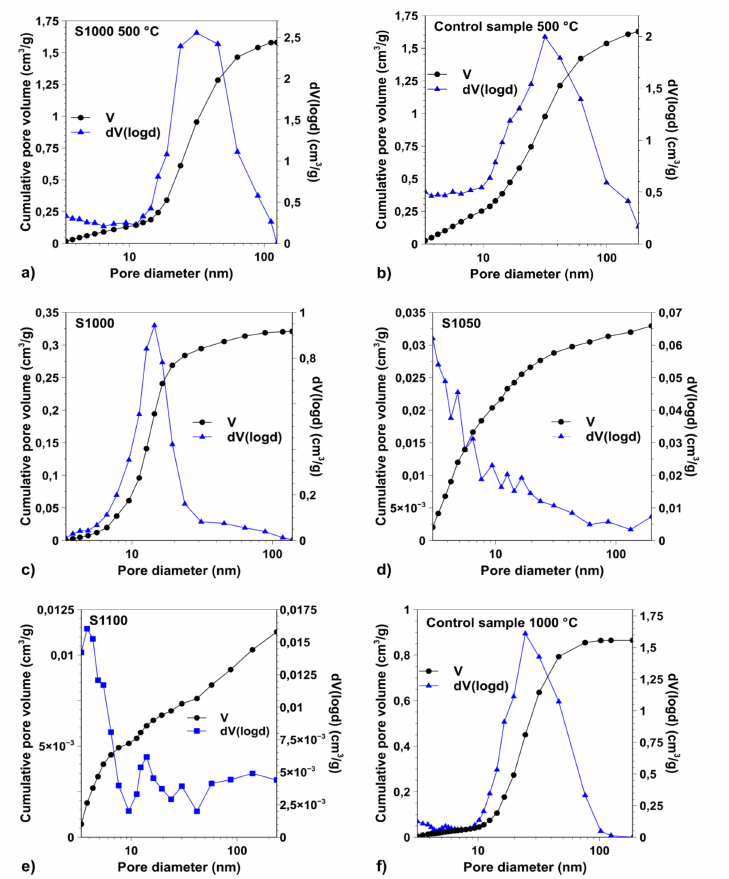
Figure 1. Pore size distribution ( (cid:78) ) and cumulative pore volume ( ) curves determined by the BJH method. The samples calcined at 500 ◦ C had a high specific surface area, but it decreased very significantly when the heating temperature was increased to 1000, 1050, and then 1100 ◦